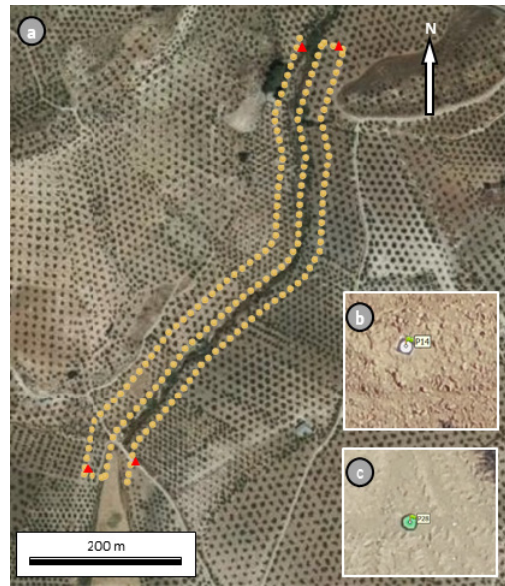
Figure 3. (a) Camera location of the reference April 2019 flight. Red triangles indicate the location of the ground control